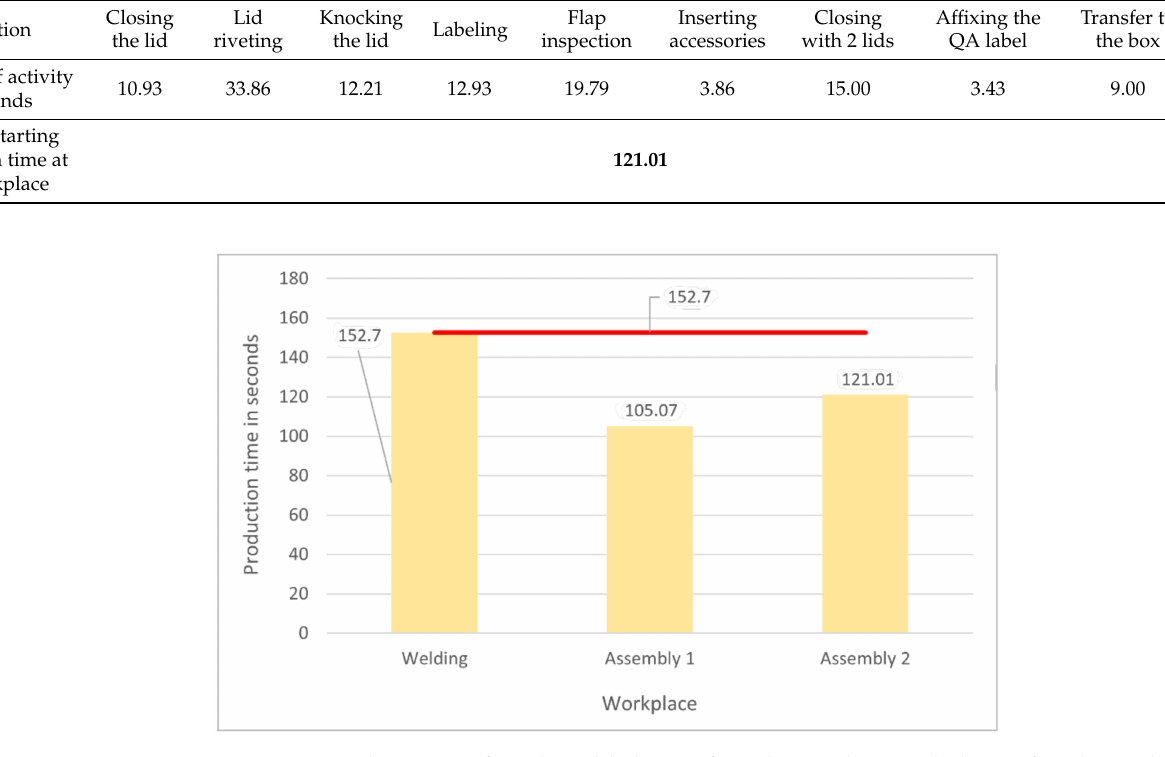
Figure 5. Baseline state of work and balance of production line workplaces after the analysis of